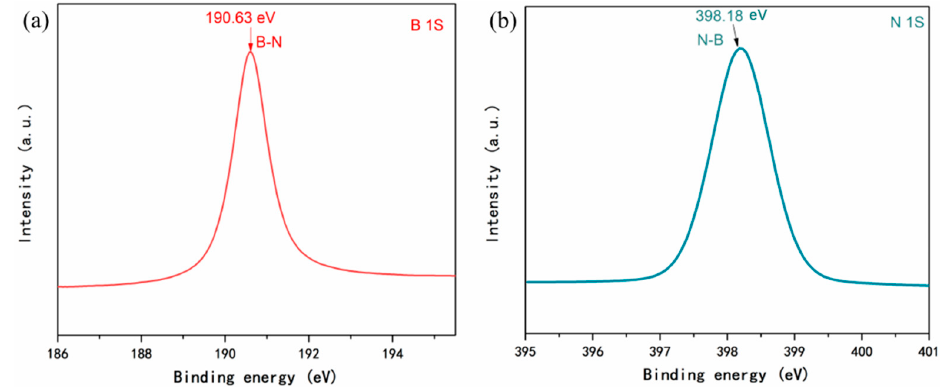
Figure 7. XPS peaks of h-BN. ( a ) B 1s, ( b ) N